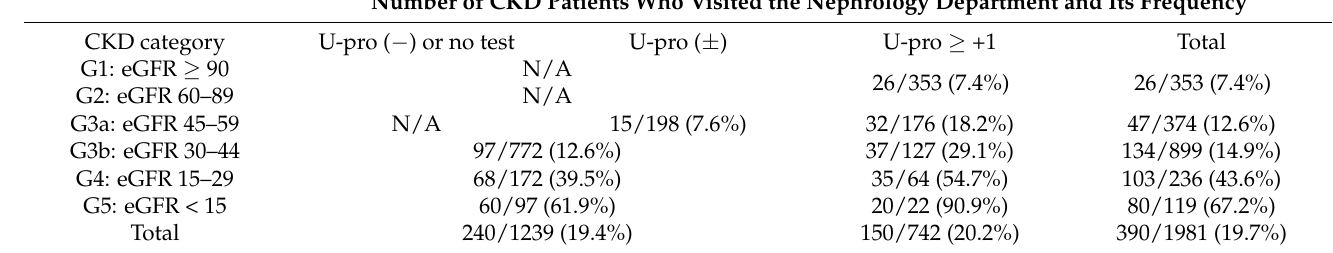
Table 4. Frequency of referral to nephrologists within 1 year of CKD